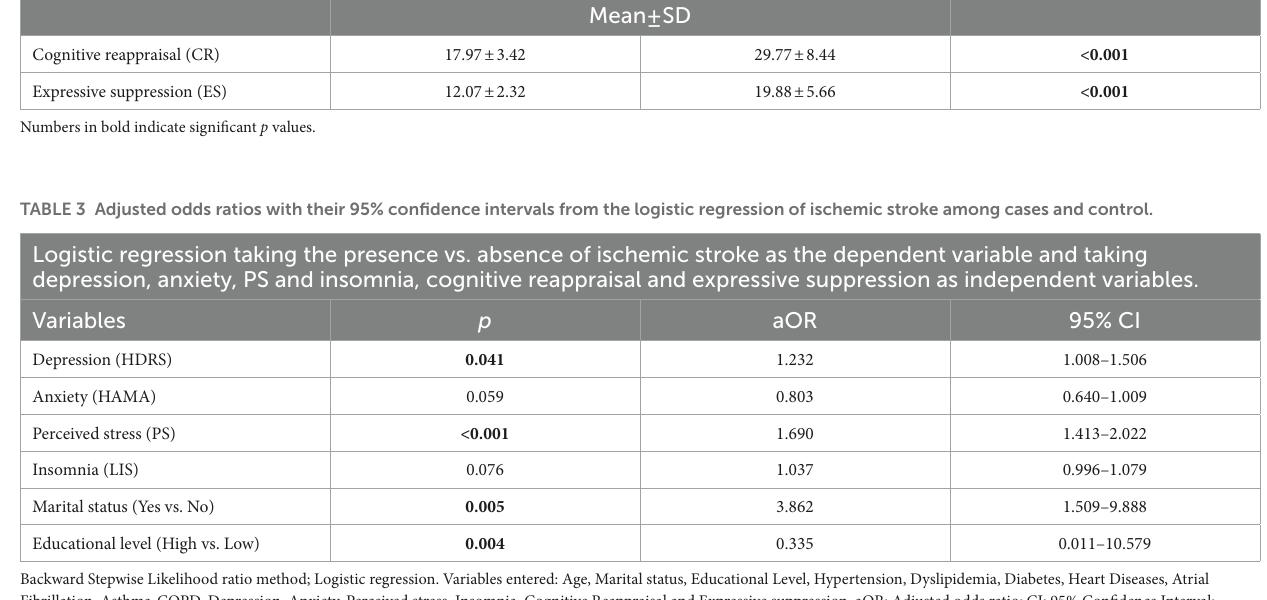
(Table 4: Model 3: CR*PSS: aOR: 0.978, 95% CI: 0.966–0.990), insomnia (Table 4: Model 4: CR*LIS: aOR: 0.994, 95% CI: 0.989–1.000; Model 5: CR*LIS: aOR: 0.986, 95% CI: 0.977–0.995) and